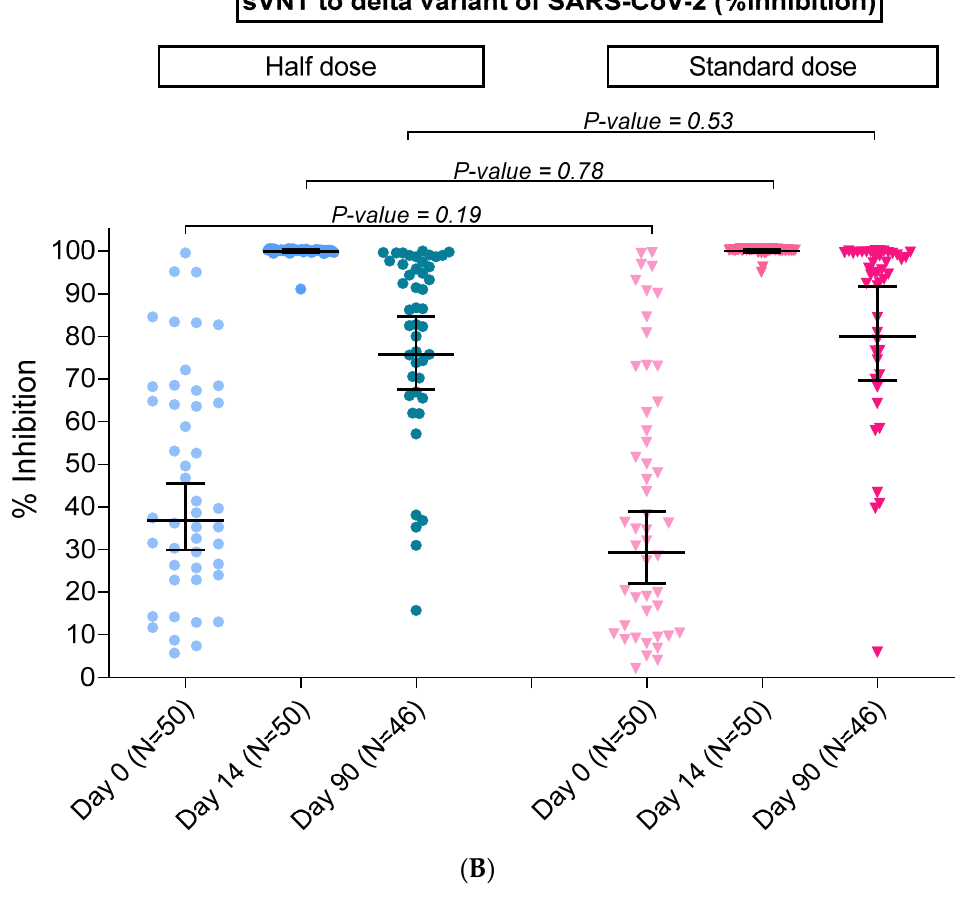
Figure 2. Geometric means (95% CI) of ( A ). sVNT for omicron variant of SARS ‐ CoV ‐ 2 (% inhibition) at day 14 and day 90 after BNT162b2 booster doses, ( B ). sVNT for delta variant of SARS ‐ CoV ‐ 2 (% inhibition) at day 0 (before BNT162b2 booster doses), day 14, and day 90 after booster doses, in adults post ‐ 2 doses of AZD1222, according to half ‐ dose and standard ‐ dose groups. sVNT: Surrogate virus neutralization test.